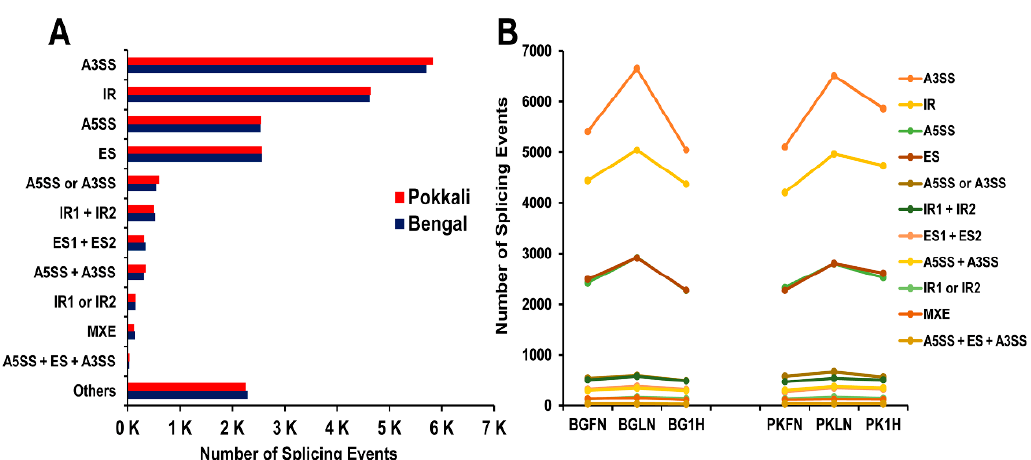
Figure 10. Annotation of alternate splicing (AS) events in the root transcriptome of rice. ( A ) Distribution